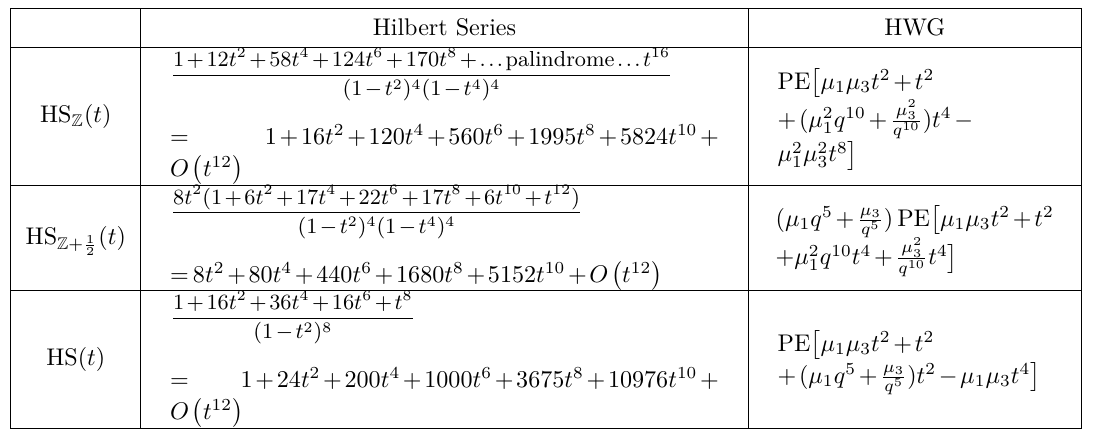
Table 11. Hilbert series for the E 4 magnetic quiver (3.7). The first line of the table provides the Hilbert series when the GNO magnetic lattice is integer HS Z ( t ) , the second line shows the sum over the integers-plus-half lattice HS Z ( t ) and the last line is their sum HS( t ) . In the third + 1 2 column, we show the HWG in terms of fugacities for su (4) (denoted µ 1 , . . . , µ 3 ) and u (1) (denoted q ). Note that the q -charge is normalized, such that the branching of su (5) → su (4) × u (1)